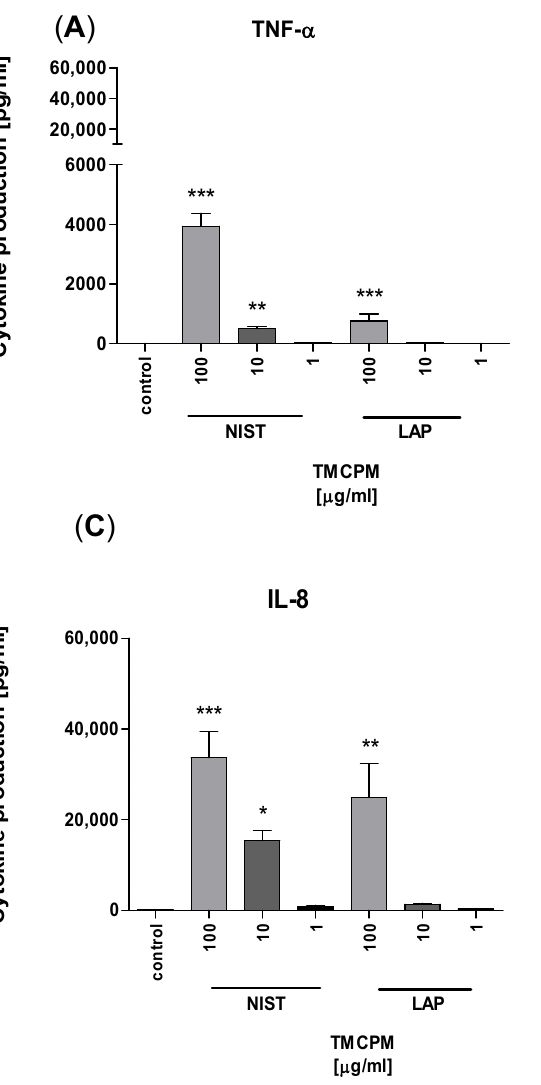
Figure 5. E ff ect of TMCPM (LAP or NIST) on cytokine production by purified human monocytes. Figure 5. Effect of TMCPM (LAP or NIST) on cytokine production by purified human monocytes. Monocytes were stimulated with LAP or NIST at three di ff erent concentrations (1 µ g / mL, 10 µ g / mL, Monocytes were stimulated with LAP or NIST at three different concentrations (1 μg/mL, 10 μg/mL, 100 µ g / mL). Concentrations of TNF- α ( A ), IL-6 ( B ), and IL-8 ( C ) in culture supernatants were determined 100 μg/mL). Concentrations of TNF-α ( A ), IL-6 ( B ), and IL-8 ( C ) in culture supernatants were p values: * p < 0.1, ** p < 0.01, *** p < 0.001, **** p <